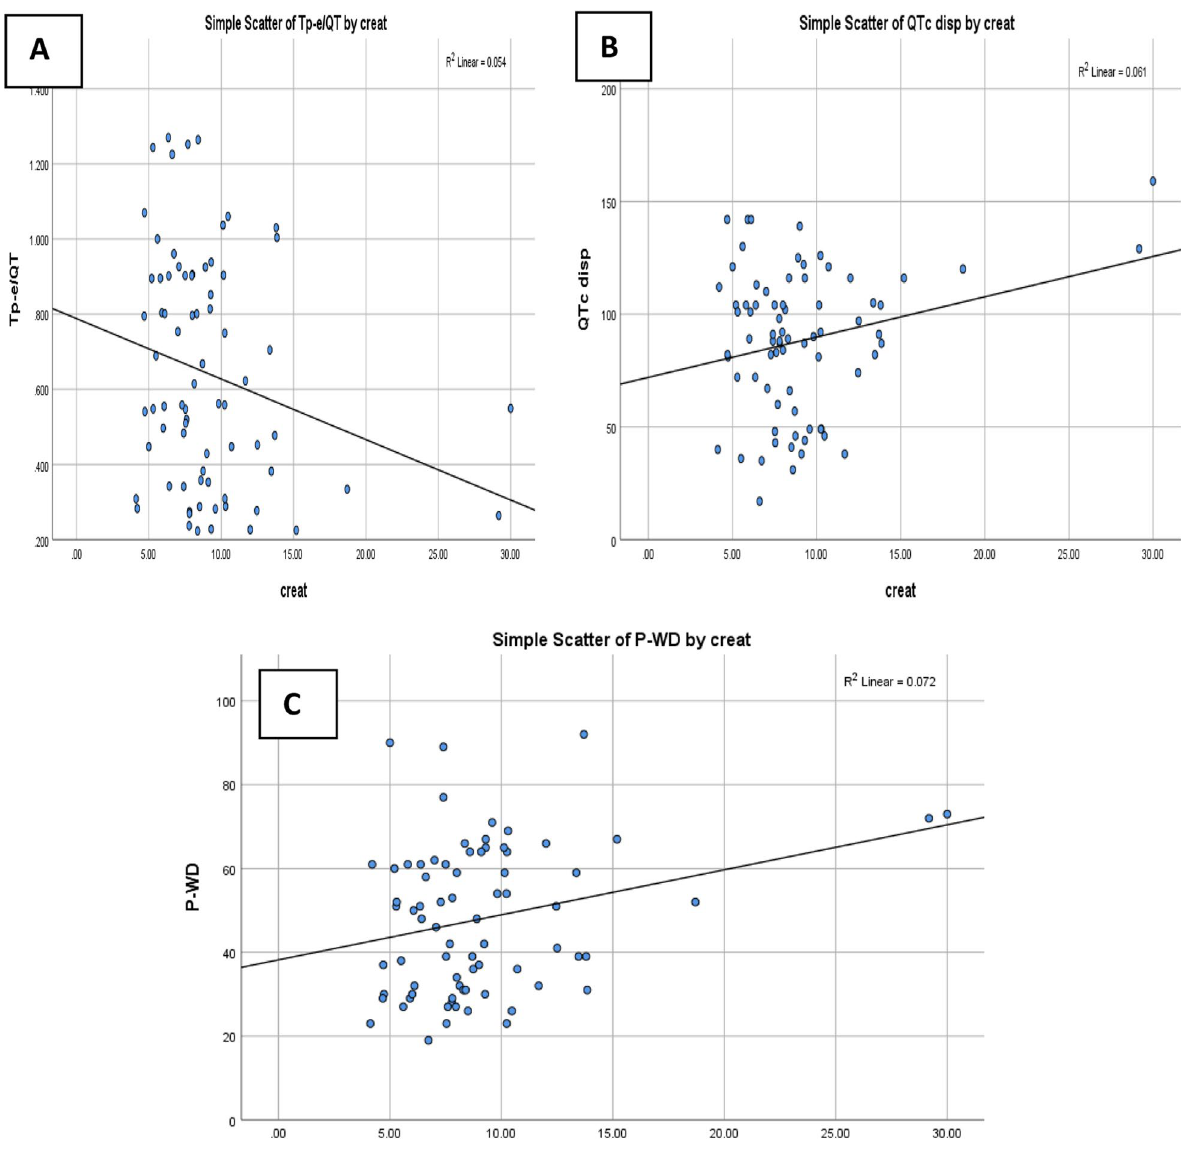
Fig. 2 A : Correlation between serum creatinine level and Tp-e/QT in ESRD, B : Correlation between serum creatinine level and QTc in ESRD, C : Correlation between serum creatinine level and P-WD in